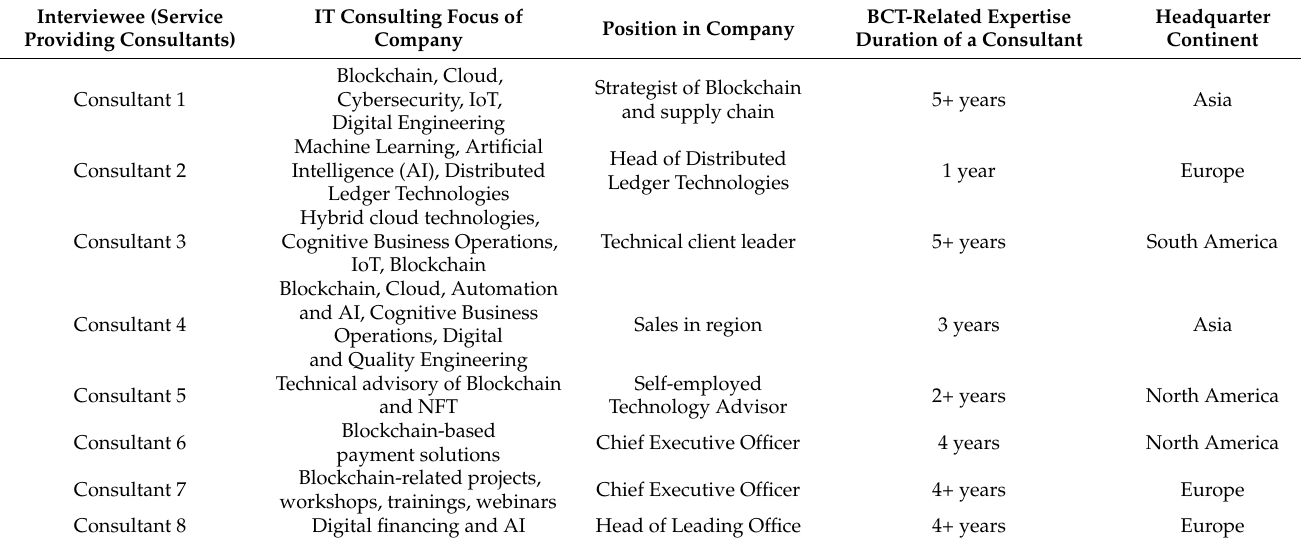
Table 2. Characterization of technology providing consultants representatives.